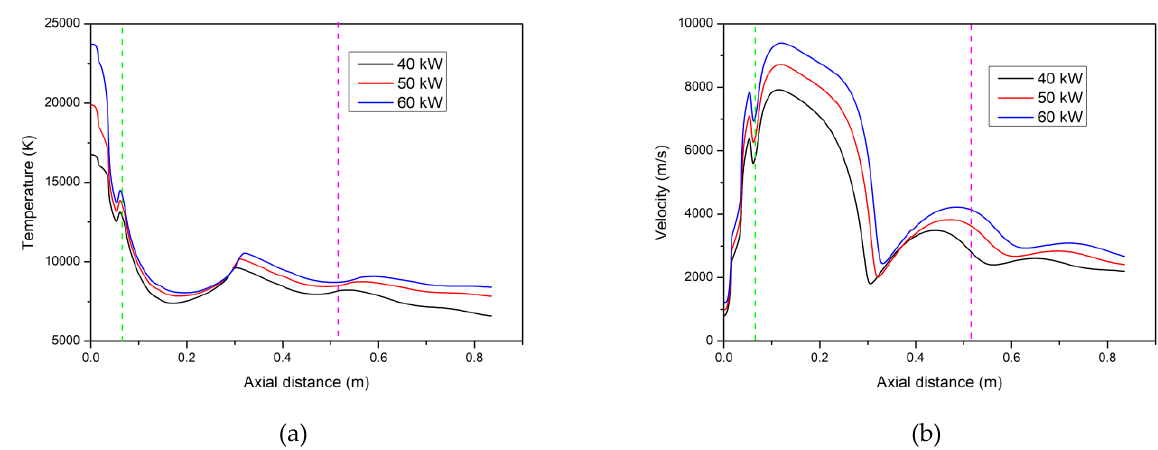
Figure 4. Variation of the temperature ( a ) and velocity ( b ) of the plasma jet along the jet axis for different net electric powers. 40 SLPM of argon, 8 SLPM of hydrogen, chamber pressure: 100 Pa. The green vertical dotted line indicates the location of the plasma torch nozzle exit.The purple vertical dotted line indicates the location of the substrate during actual coating deposition.